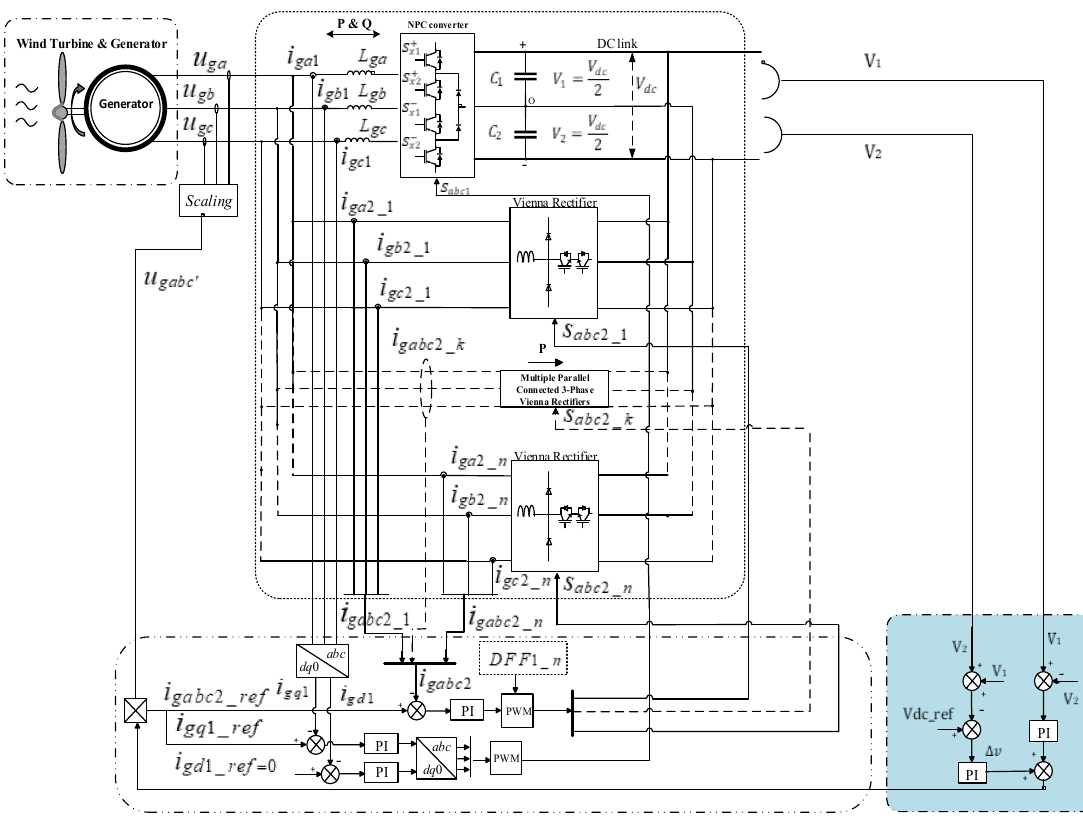
Figure 3. Proposed hybrid converter for multi-MW wind generator.